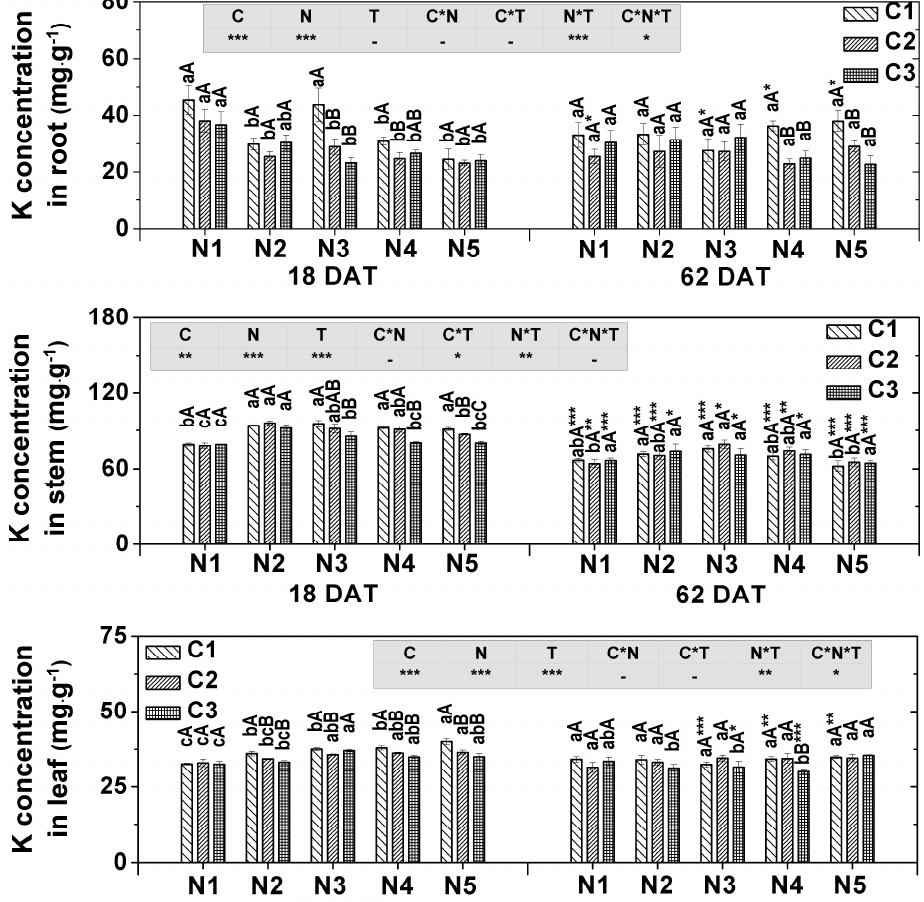
Figure 4. Potassium concentrations in different tissues of cucumber plants grown under different N and [CO 2 ] levels at two growth stages ( n = 6). Bars represent standard errors. CO 2 levels: C1, C2, and C3: 400, 625, and 1200 µ mol mol − 1 . N levels: N1, N2, N3, N4, and N5: 2, 4, 7, 14, and 21 mmol L − 1 .